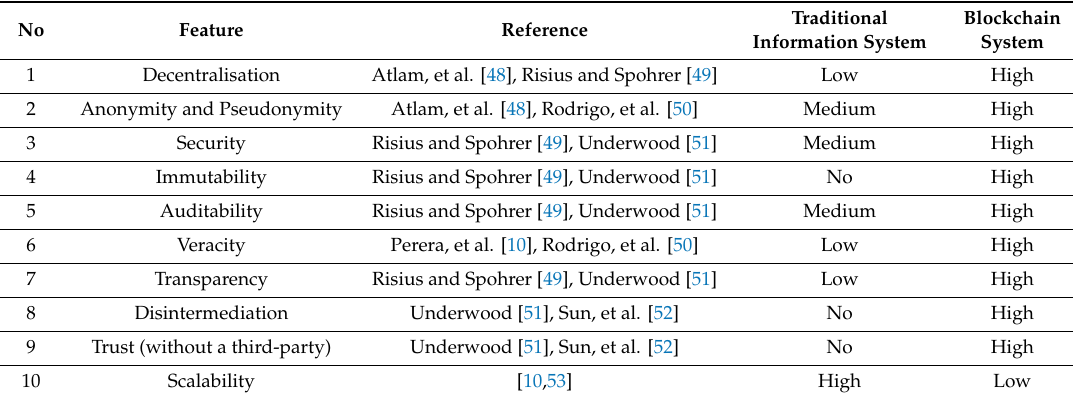
Table 2. Comparison of features between a traditional information system and a blockchain